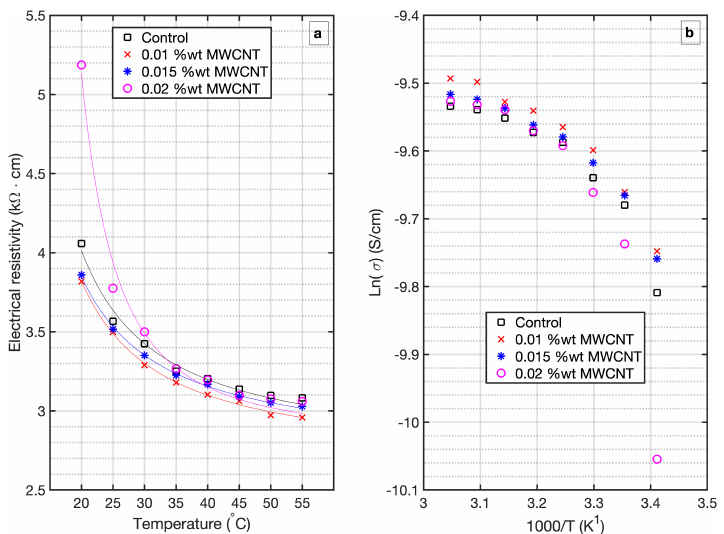
Figure 6. Thermal evolution of electrical resistivity of MWCNT-mortar at 90 days curing time ( a ), and Arrhenius plots for MWCNT-mortar at 90 days curing time presented over the temperature range 20–55 ◦ C ( b ). Table 6. Summary of activation energy values, calculated with Arrhenius equation of MWCNTs- mortar at 90 days curing time. Conductivity of the MWCNT-mortar at 20 ◦ C, σ 20 is also presented. MWCNT